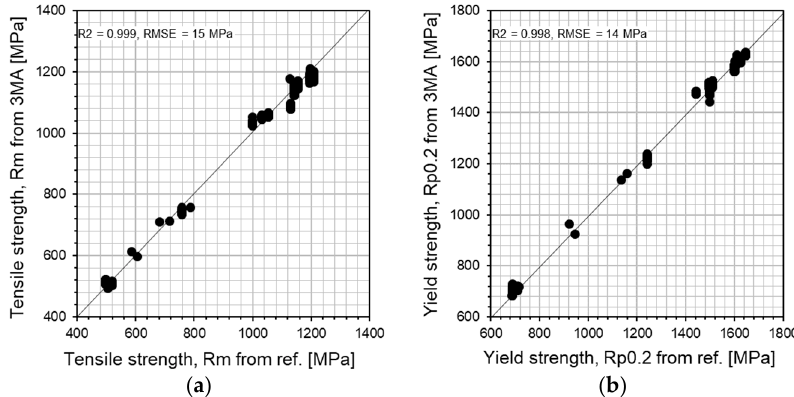
Figure 18. Results of the calibration for the mechanical properties in AlSi-coated Press-Hardened Steel (PHS): ( a ) tensile strength and ( b ) yield strength. Appl. Sci. 2019 , 9 , x FOR PEER REVIEW